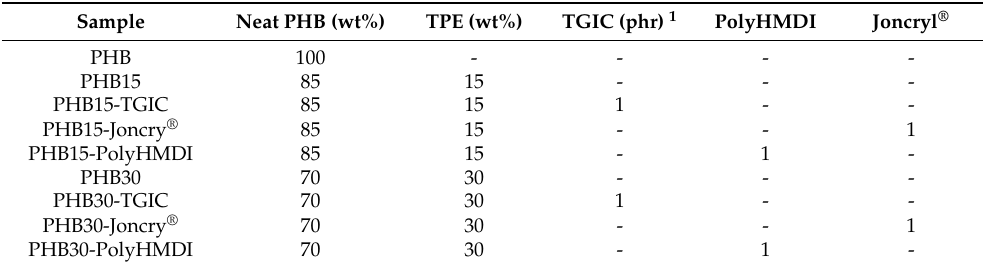
Table 1. List of compounds and their